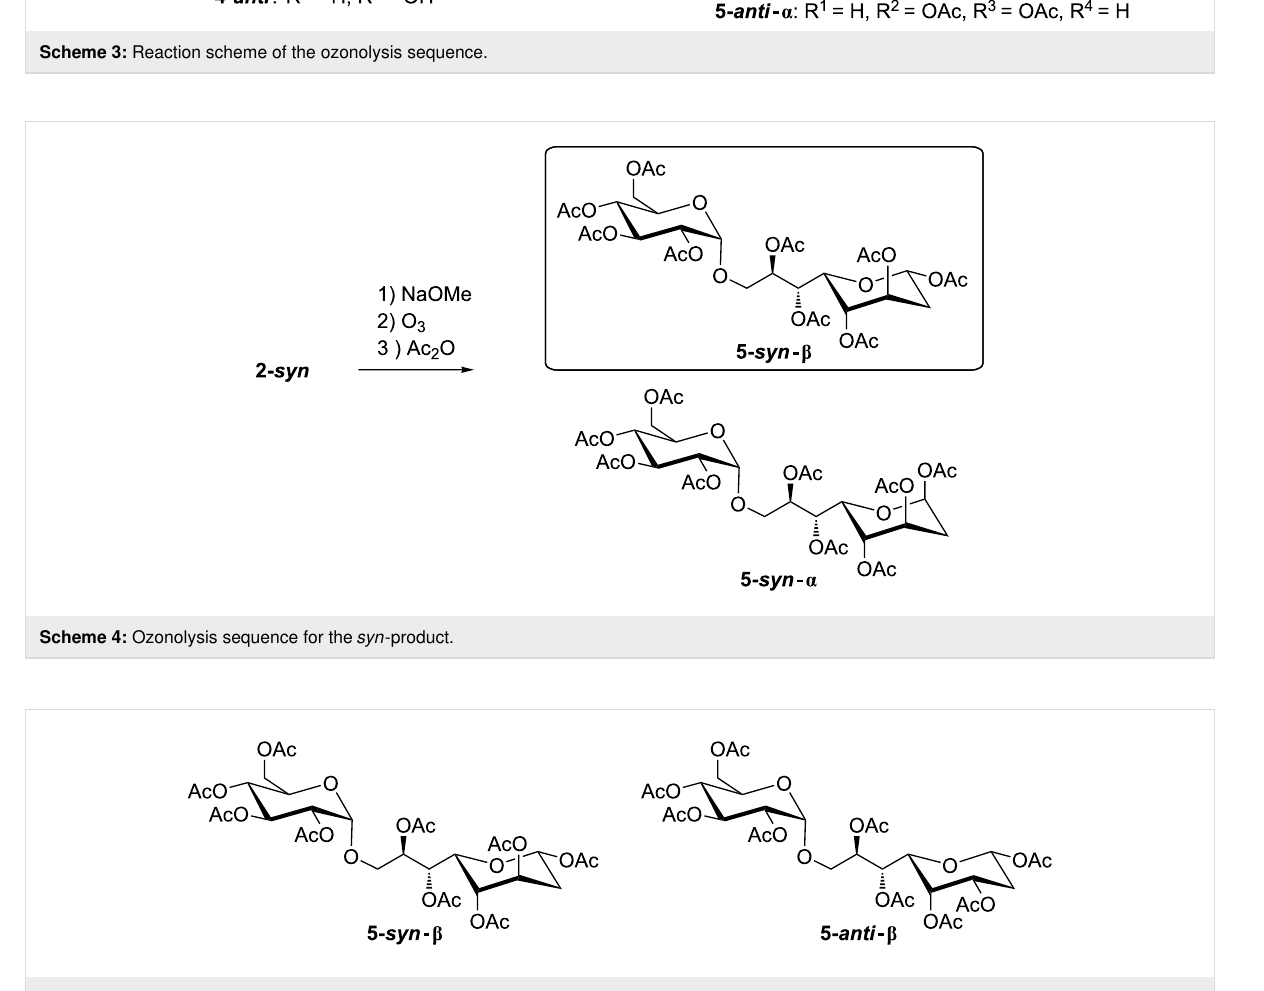
Scheme 3: Reaction scheme of the ozonolysis sequence.